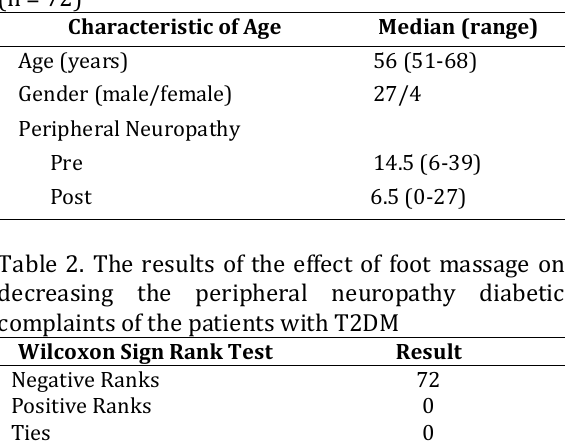
Table 1. General characteristics of the respondents